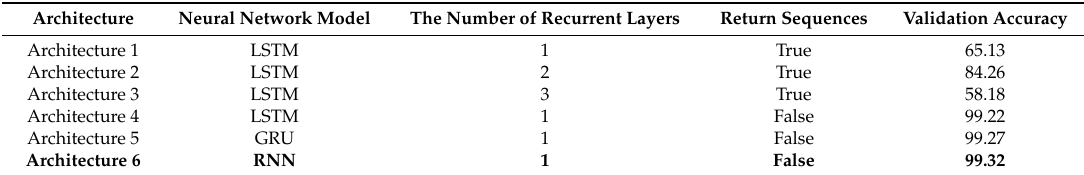
Table 2. Some designed architectures to select the best architecture. LSTM: Long Short-Term Memory; GRU: Gated Recurrent Unit; RNN: Recurrent Neural